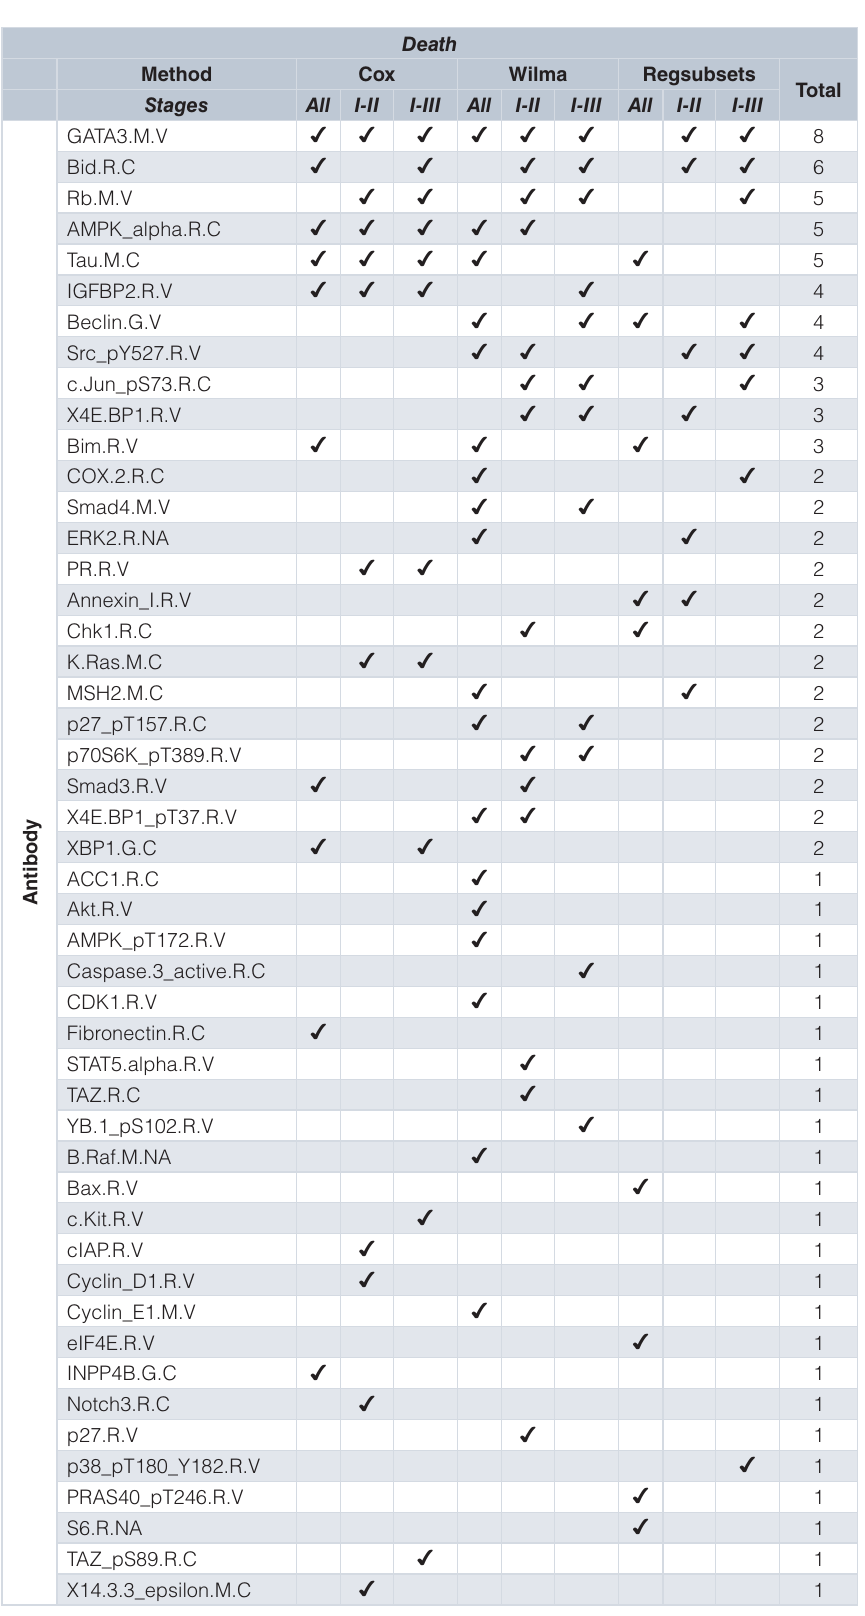
Supplemental Table 3. All proteins associated with death, sorted in descending order by the number of times